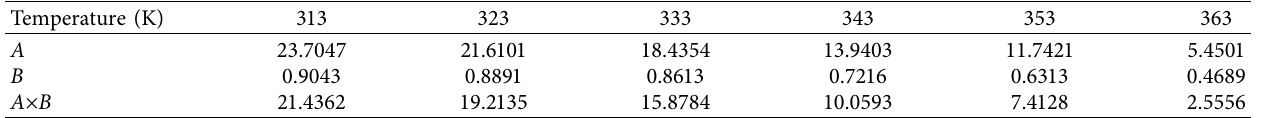
Table 3: Parameters of equation (3) calculated by the fitting